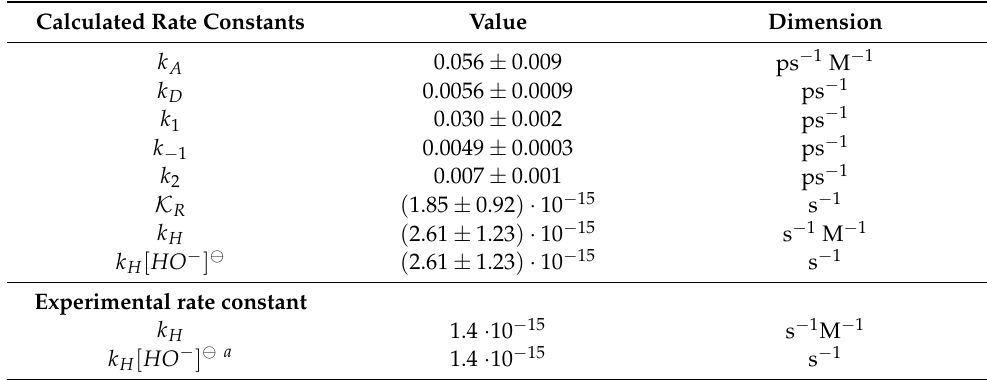
Table 1. Kinetic rate constants of the P–O bond cleavage in Np 2 P − . Calculated Rate Constants Value Dimension k A 0.056 ± 0.009 ps − 1 M − 1